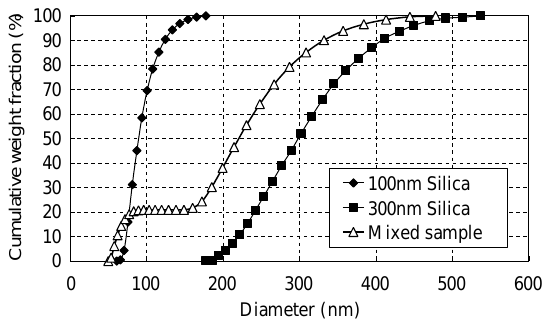
Fig. 1 Size distribution of silica particles used in the experiment.